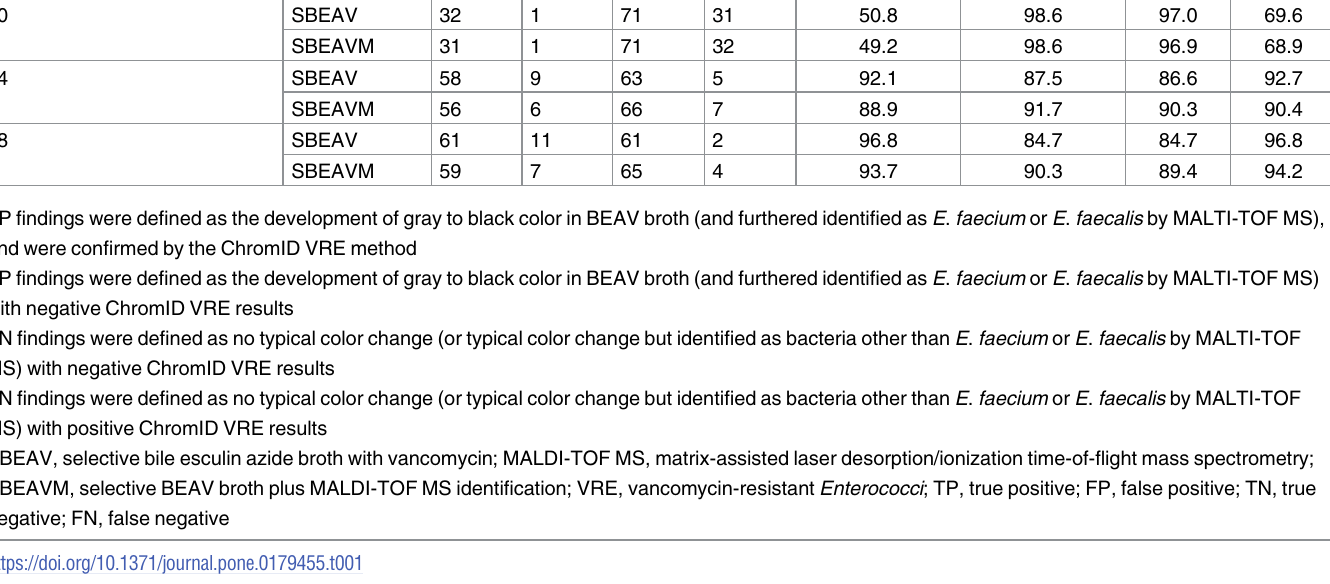
Table 1. Comparison of the selective BEAV broth (SBEAV) and selectiveBEAV broth plus MALDI-TOF MS identification (SBEAVM) methods at incubation periods of 20, 24, and 28 hours. Incubation period (hours)